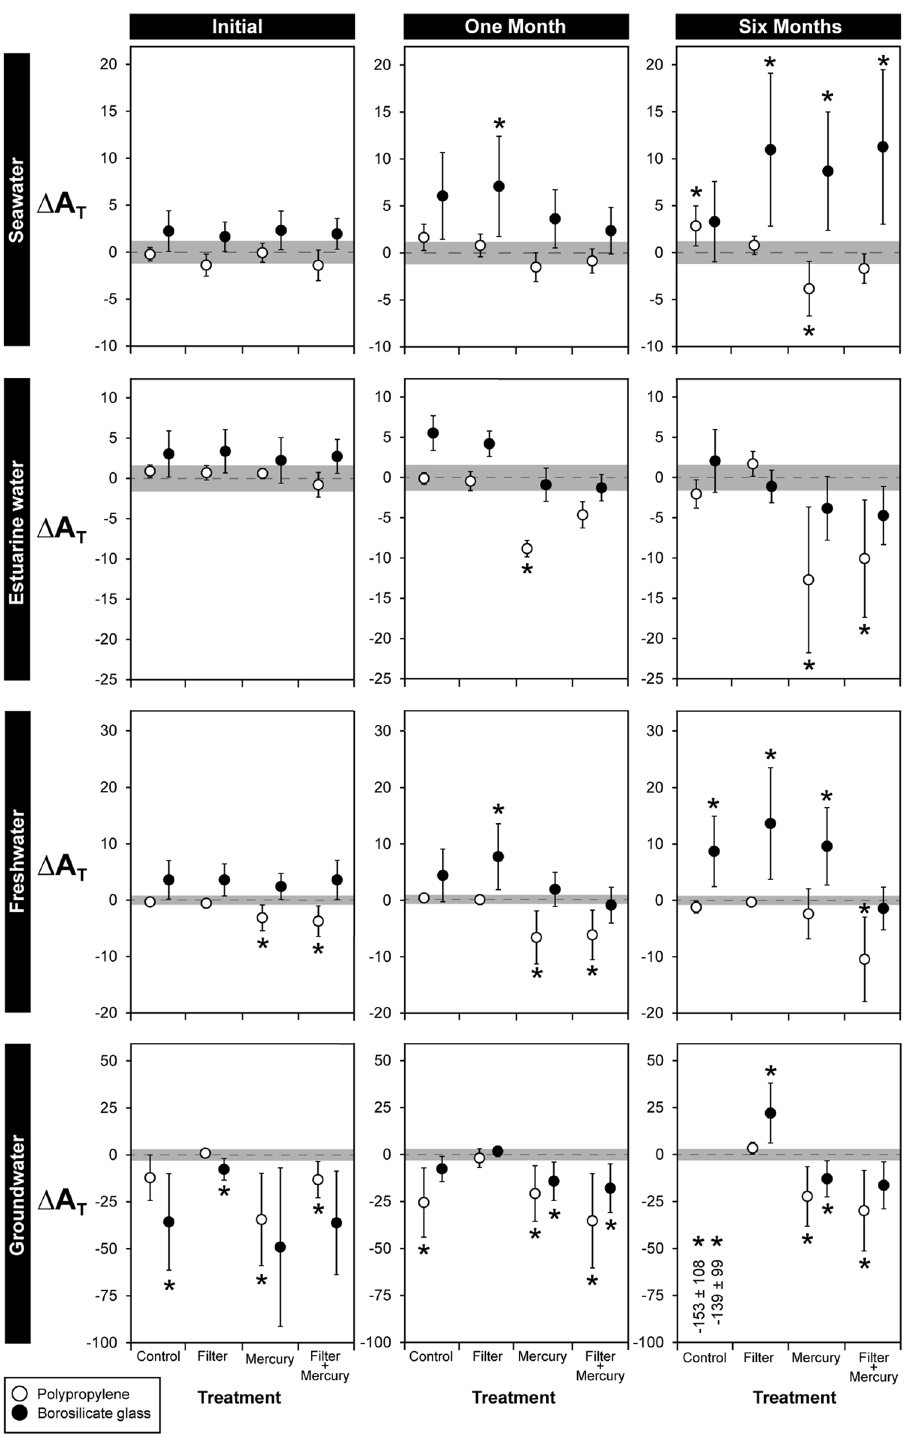
Figure 1. The effects of storage vessel material and preservation method on difference in total alkalinity (∆A T ) of seawater, estuarine water, freshwater, and groundwater samples stored for 0, 1, and 6 months. All results represent the difference between observations and the mean A T of untreated samples measured at the beginning of the experiment (A T values of benchmark controls shown in Table 1). Water samples were treated using one of four methods (no treatment; 0.45 µm filter; 100 µL saturated HgCl 2 solution (25 °C); filter + HgCl 2 ). Samples were then stored in either polypropylene (white) or borosilicate glass (black) vials at 4 °C for 0, 1, or 6 months. Shaded areas on graphs represent ± 2 standard deviations of the respective benchmark control (Table 1). Asterisks indicate there was a significant difference in A T of samples in a treatment compared to the A T of the benchmark control according to Dunnett’s tests, and should not be used to evaluate statistical difference or similarity among treatments. Data are means ± 1 standard deviation. n = 5 except for the seawater 6 months/ glass/Control treatment where n = 4. As mean ∆A T for the groundwater 6 month/Control treatments were greater than –100 µmol kg −1 , values are given on the figure (means ± 1